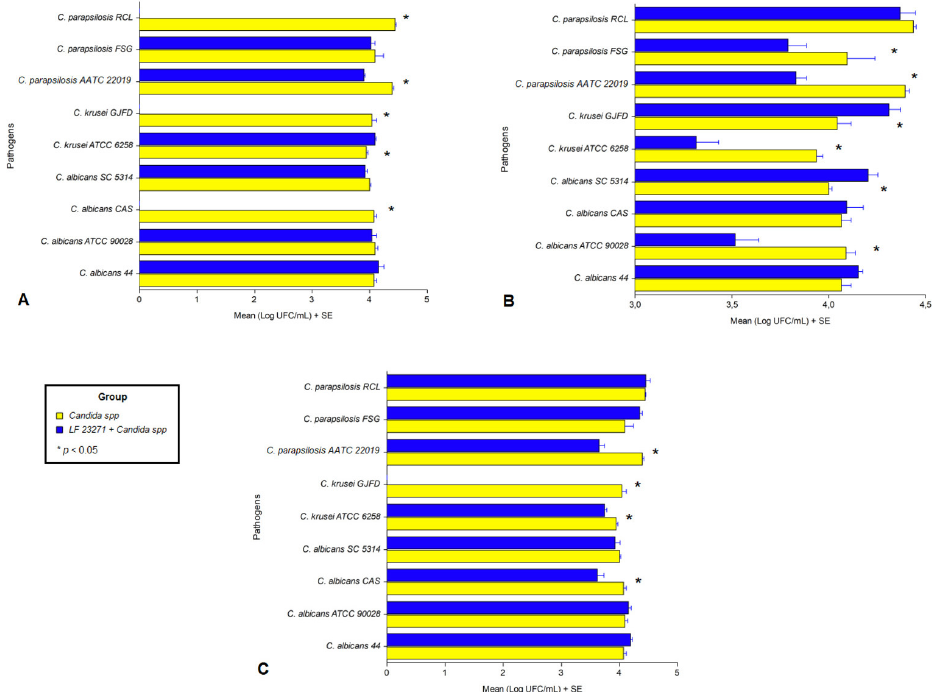
Figure 9. Inhibition of adhesion of Candida strains to eukaryotic cells by L. fermentum ATCC 23271 in three experiments: ( A ) competition, ( B ) exclusion and ( C ) displacement. * Represents the strains that had their adhesion to eukaryotic cells significantly influenced by L. fermentum ATCC 23271.